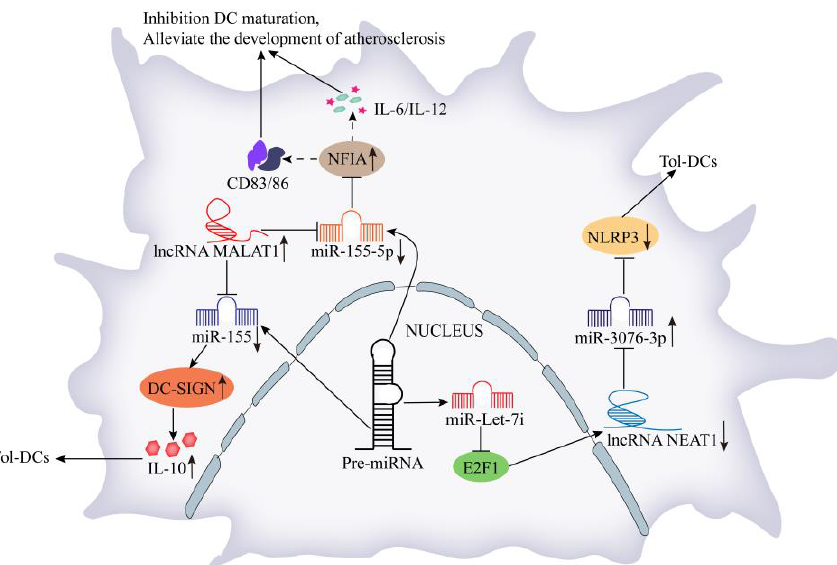
Figure 2. Mechanism of the regulatory role of lncRNAs in dendritic cells. MiR-let-7i regulates the expression of lncRNA NEAT1 by binding E2F1, and the downregulated lncRNA NEAT1 promotes the polarization of DCs to a more tolerant phenotype via miR-3076-3p/NLRP3 axis. LncRNA MALAT1 promotes DC-SIGN and IL-10 by targeting miR-155 in the cytoplasm of DCs, thereby regulating the formation of tolerogenic DCs. Overexpression of lncRNA MALAT1 inhibits DC maturation by regulating the miR-155-5p/NFIA axis.